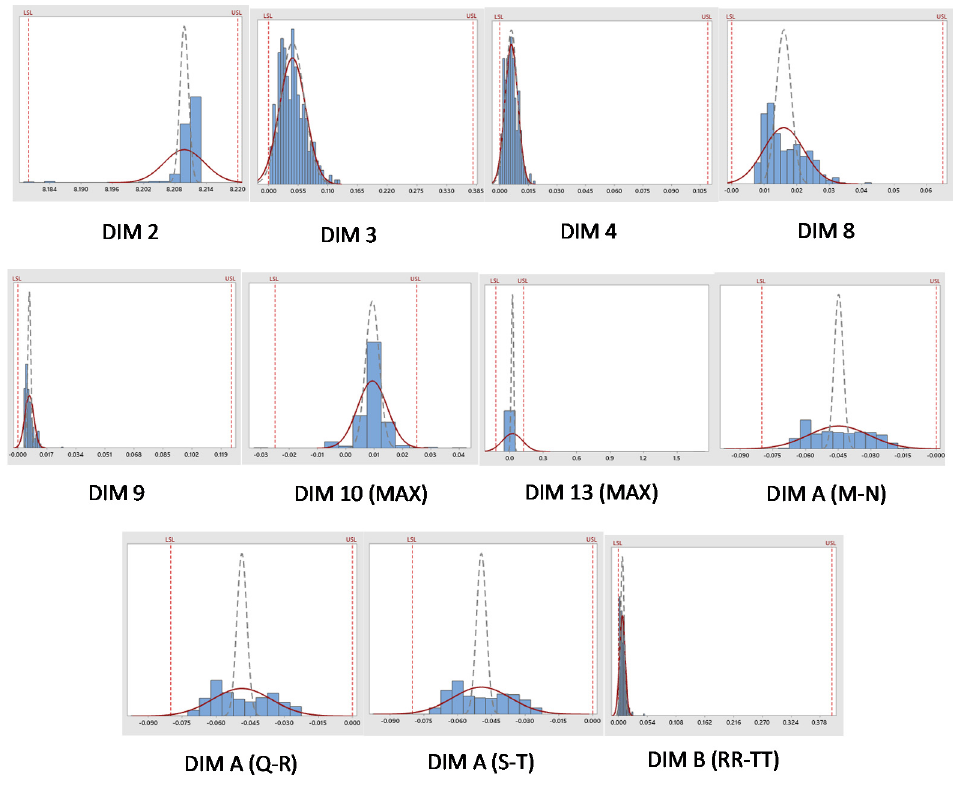
Figure 14. Histogram for low capability DIMs.